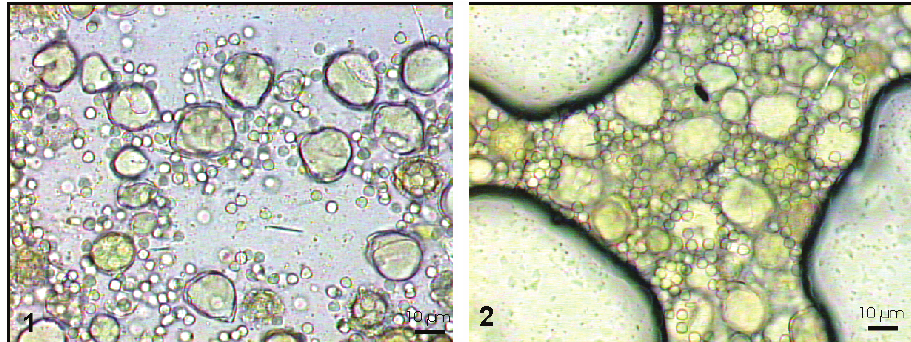
Fig. 1 – A pool of pollen loads prepared using technique 2; pollen grains are well dispersed all over the slide. Fig. 2 – A pool of pollen loads prepared using technique 2 three weeks later; the slide started to dry, and the pollen grains overlapped and were pressed against the air